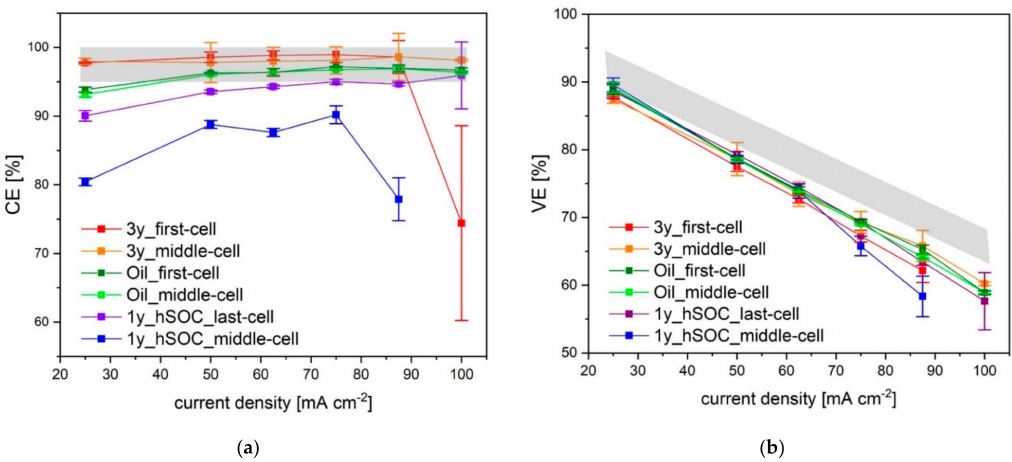
Figure 1. Coulombic efficiencies ( a ) and voltage efficiencies ( b ) of membranes retrieved from decommissioned stacks, grey zone = pristine, standard deviation of five